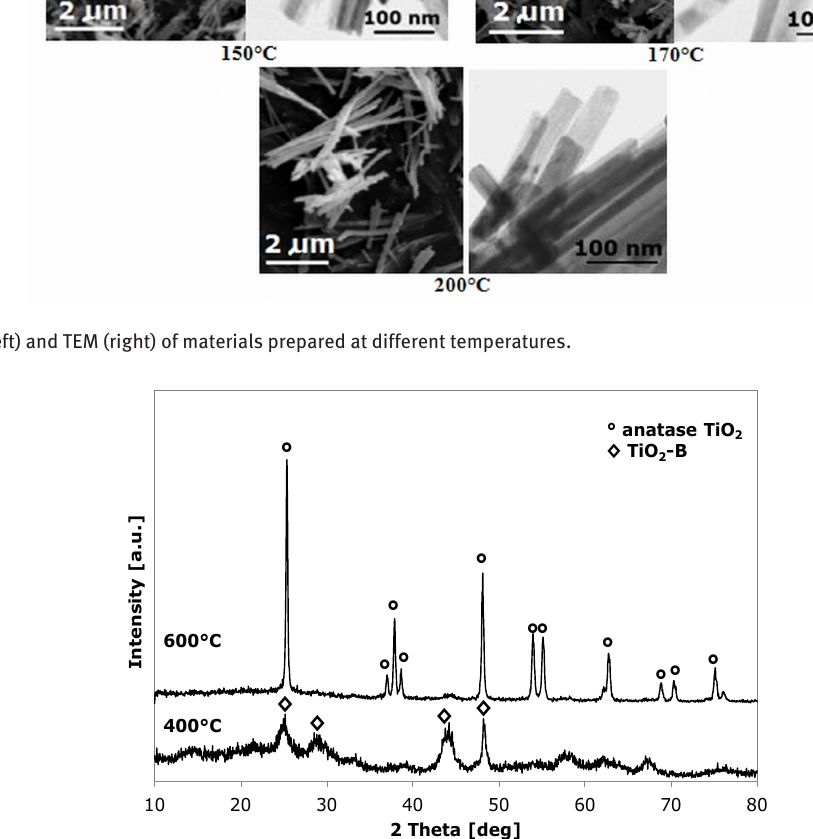
Figure 4: XRD of TiO